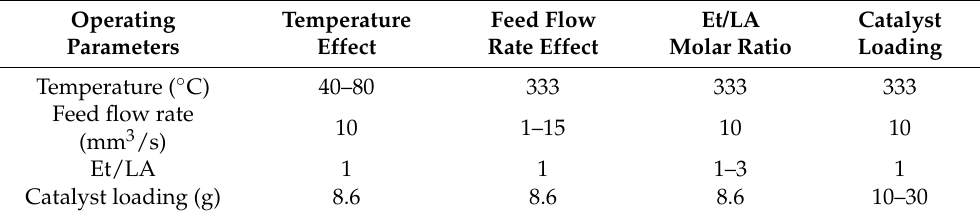
Table 6. The investigated conditions for MB-PVMR and MB-TR during LA-ESR